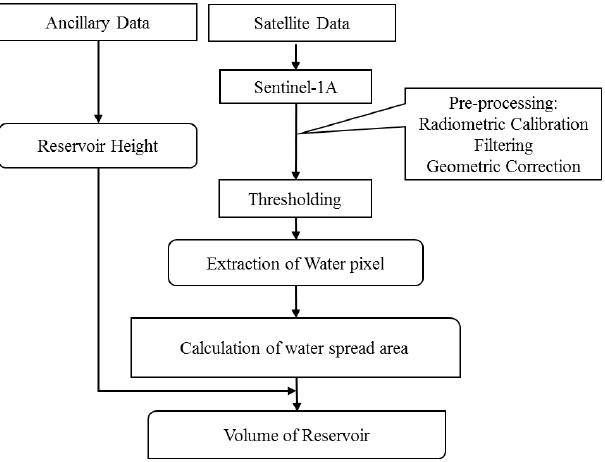
Figure 2. Overall Methodology flow chart